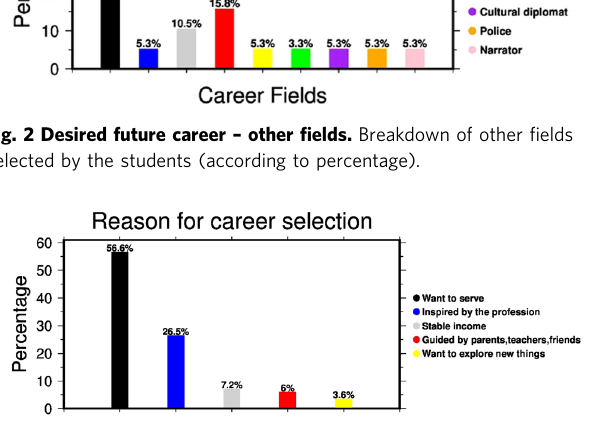
Fig. 3 Reason for career selection. Reason for the future career